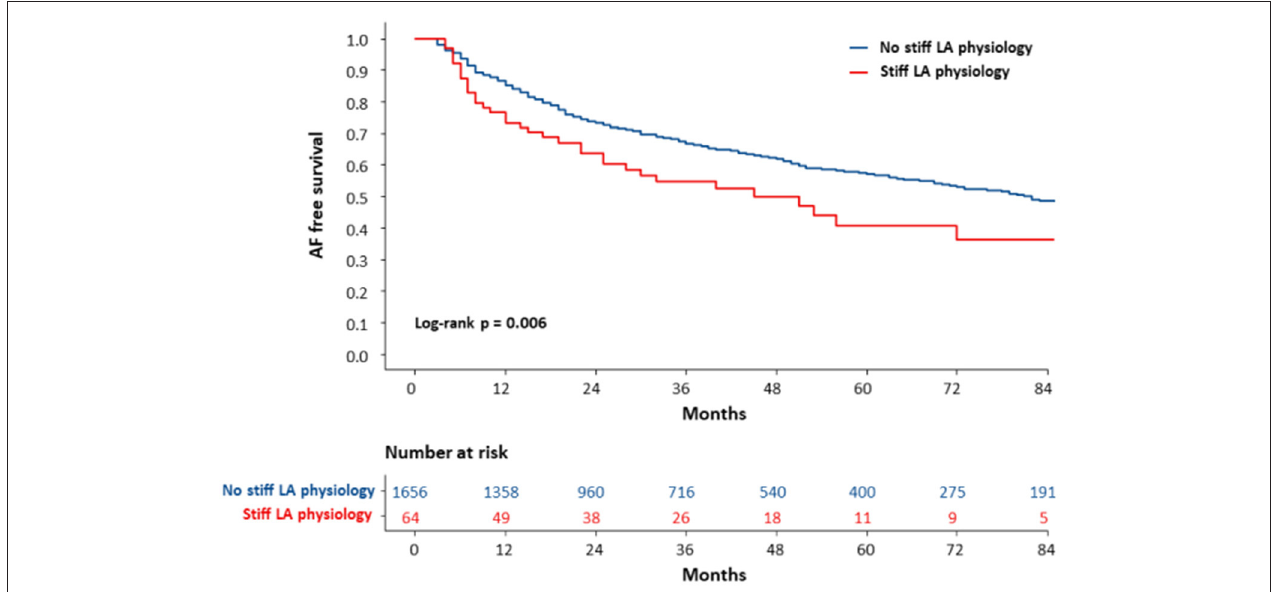
FIGURE 4 | The Kaplan-Meier curve for clinical recurrence of AF according to the development of stiff LA physiology. The clinical recurrence of AF was worse in patients with stiff LA physiology (log-rank p = 0.006). AF, atrial fibrillation; LA, left atrial or left atrium; RVSP, right ventricular systolic pressure.